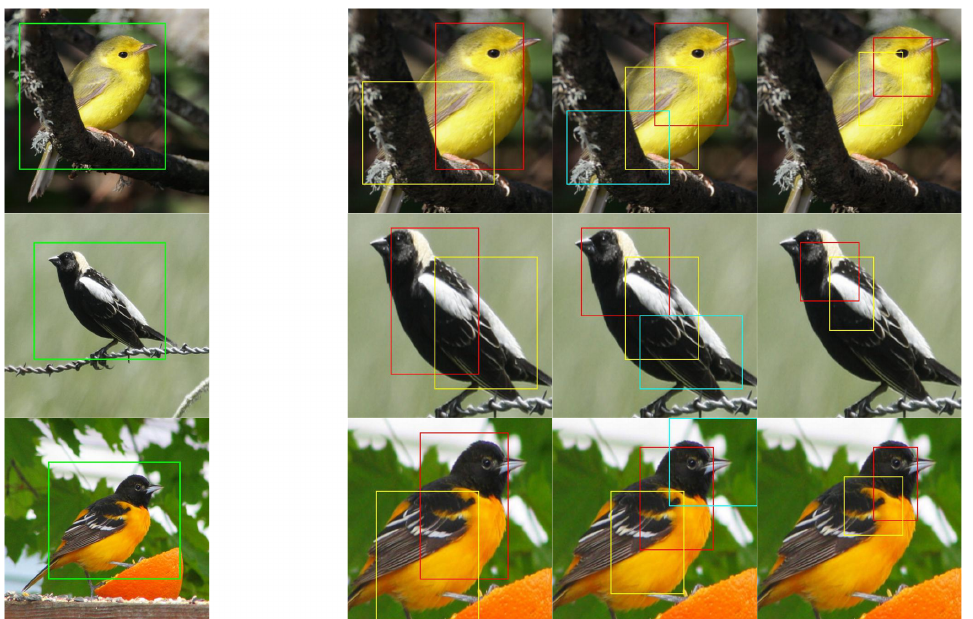
Figure 6. The localization effect visualization of the targets and local areas. In the first column, the green rectangle indicates the predicted bounding box of the object in the raw image. The second to fourth columns show the localization results of the key part regions in the target image at different scales, where the red box is the region with the largest attentional average, and the yellow and blue boxes are the regions with the second and third largest attentional values,